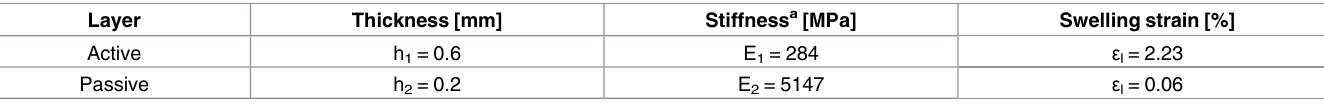
Table 2. Input parameters for FE simulation of bilayer-cell actuation.